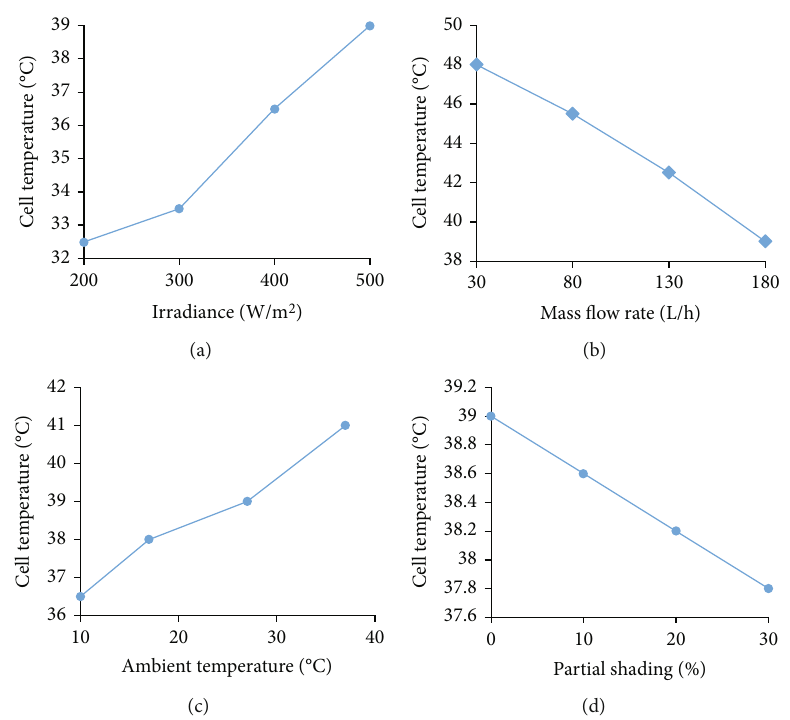
Figure 12: Outcome of (a) G , (b) V